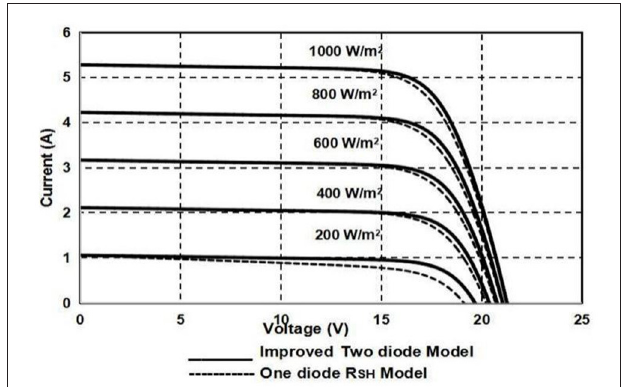
FIGURE 10 | Comparative analysis of current (A) vs. voltage (V) curve for one-diode R SH and proposed two-diode model for DS-A1-80 with different irradiance points at STC (25 ◦ C).